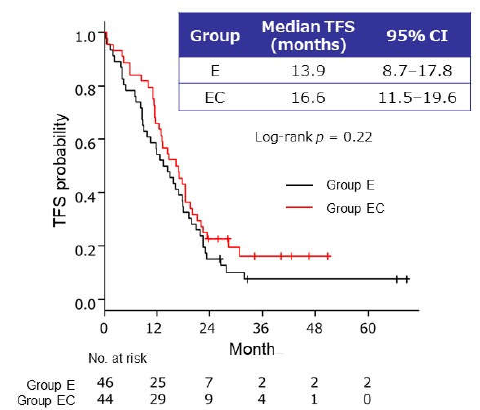
Figure 4. Kaplan–Meier curves of time to failure of strategy (TFS) from randomization in patients